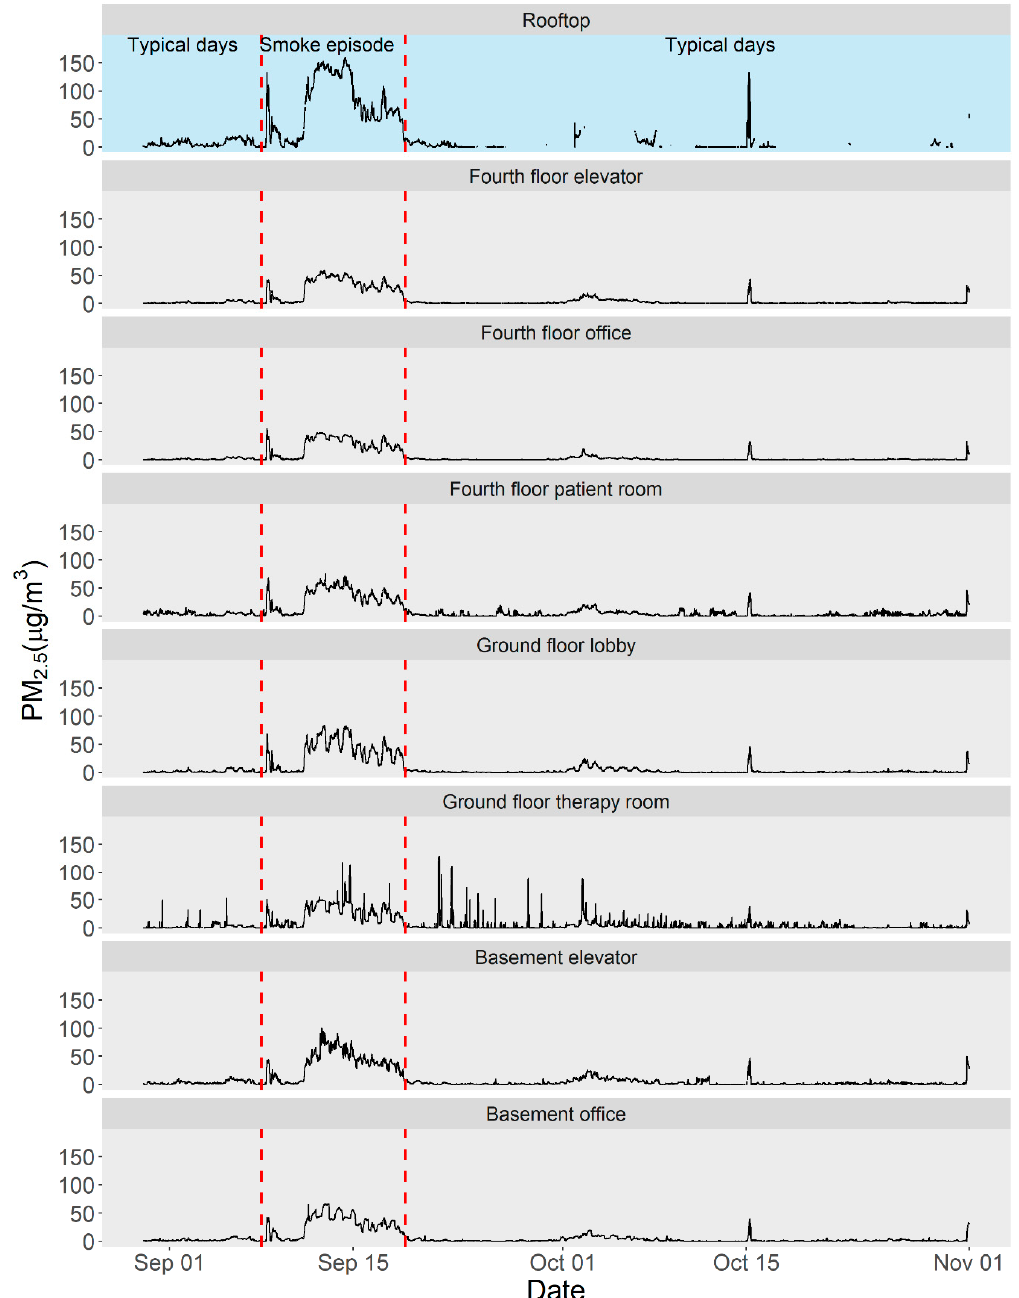
Figure 4. Time series of calibrated 1-min PM 2.5 concentrations from the low-cost sensors located outdoors (blue) and indoors (grey). Indoor peaks have not been removed from these data. The cause of the short peak on October 15 is unknown.